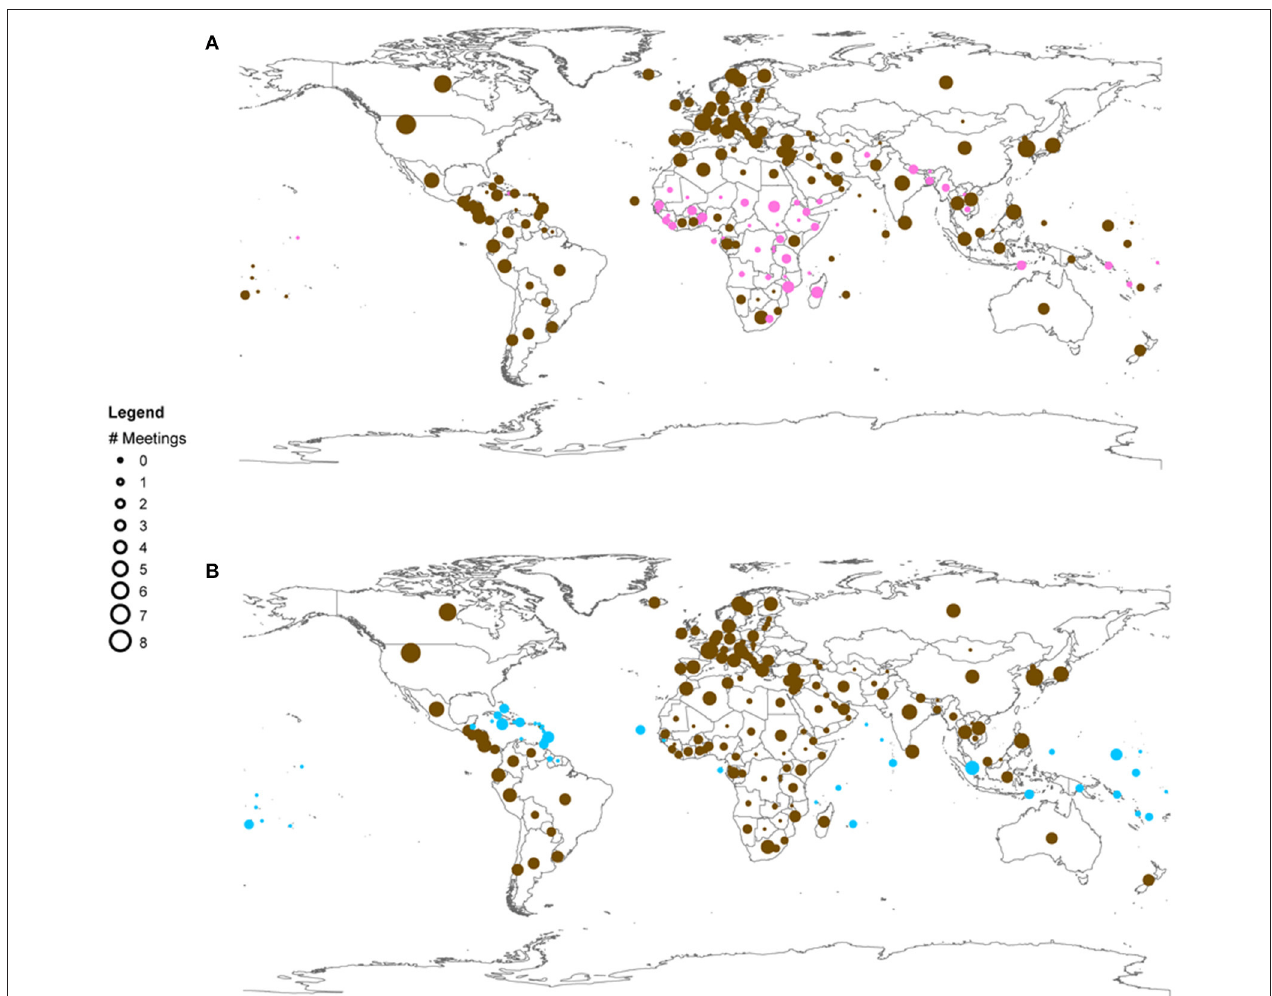
FIGURE 2 | Mapping of countries’ participation in meetings related to biodiversity in areas beyond national jurisdiction. (A) Least developed countries highlighted in pink; (B) Small island developing states highlighted in blue. The size of the circle corresponds to the number of meetings in which each country